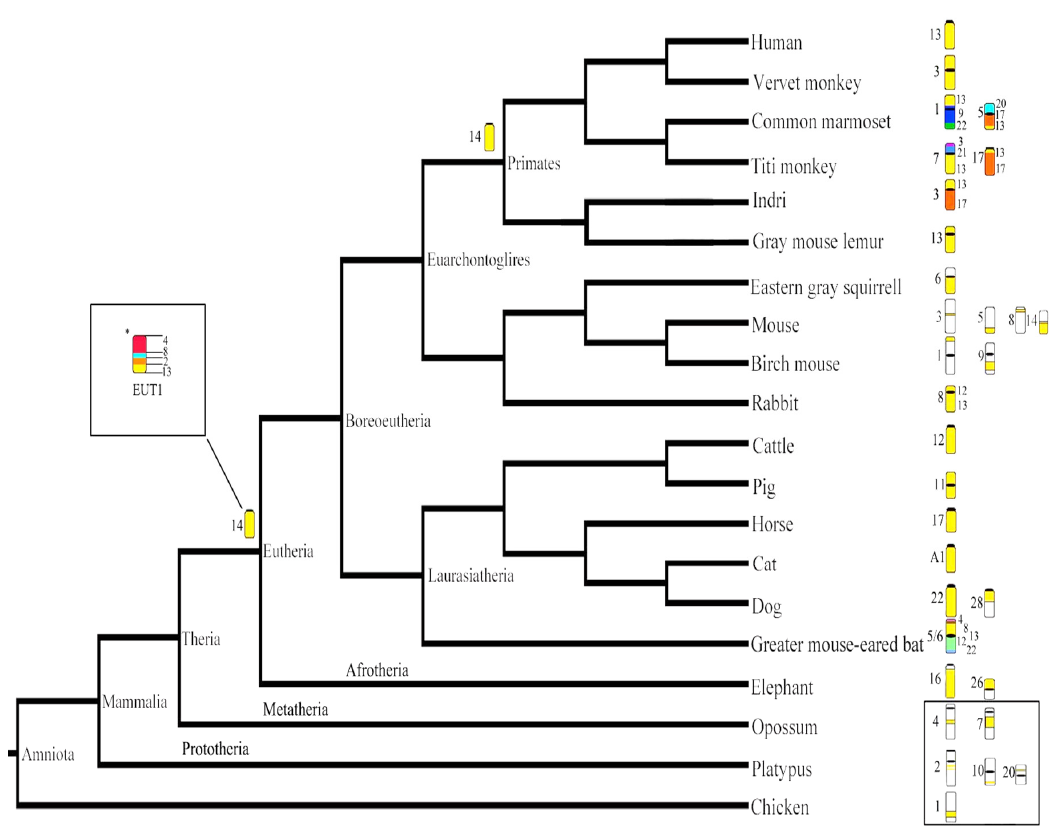
Figure 1. The mammalian phylogenetic tree show the orthologous blocks that correspond to human chromosome 13 (in yellow) in representative eutherian species for which reciprocal painting data is available; the tree presents data from Table 2. Chromosome ideograms on which human synteny 13 is found are reported for each species, and the species’ chromosome number is shown on the left of the ideograms and HSA syntenies on the right. When HSA13 synteny, yellow, is rearranged with just a few human syntenies, these are represented in different colours and are reported on the right of the ideogram (for example, in indri, chromosome 3, synteny 13 (yellow), is fused with synteny 17 (red)), while when HSA 13 (yellow) is rearranged with many other human syntenies, these are represented by white segments for logistic reasons (for example, on chicken chromosome 1). For some species, DNA sequence alignments have been done previously, see Table 2 for citations. On the tree, the ancestral synteny 13 form (chromosome 14) described by painting data analysis is reported, and the eutherian ancestral chromosome 13 (EUT 1) alternative reconstruction, obtained through sequence data, from table 2, is shown in the upon box on the right of the tree underlined with an asterisk * [23]. Platypus (Monotremata), opossum (Marsupialia) and chicken (Aves) chromosome homologues are reported in the box at the lower right; these species are representative outgroups. Synteny homologues to human chromosome 13 are on chromosomes 2, 10 and 20 in the platypus, chromosomes 4 and 7 in the opossum and chromosome 1 in the chicken. Black areas indicate the centromere. The tree topology constructed according to previous data [31], and also considering results from [23] was modified from Scardino et al. [29]